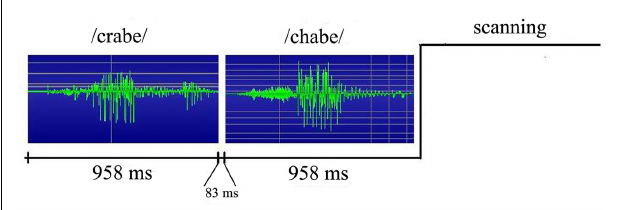
FIGURE 3 | Stimulus presentation during the auditory lexical decision task (sparse imaging procedure). A French word ( crabe ) and a yoked pseudoword ( chabe ) are presented in between acquisition scans.Trial duration was 2s with an ISI of 6 ±